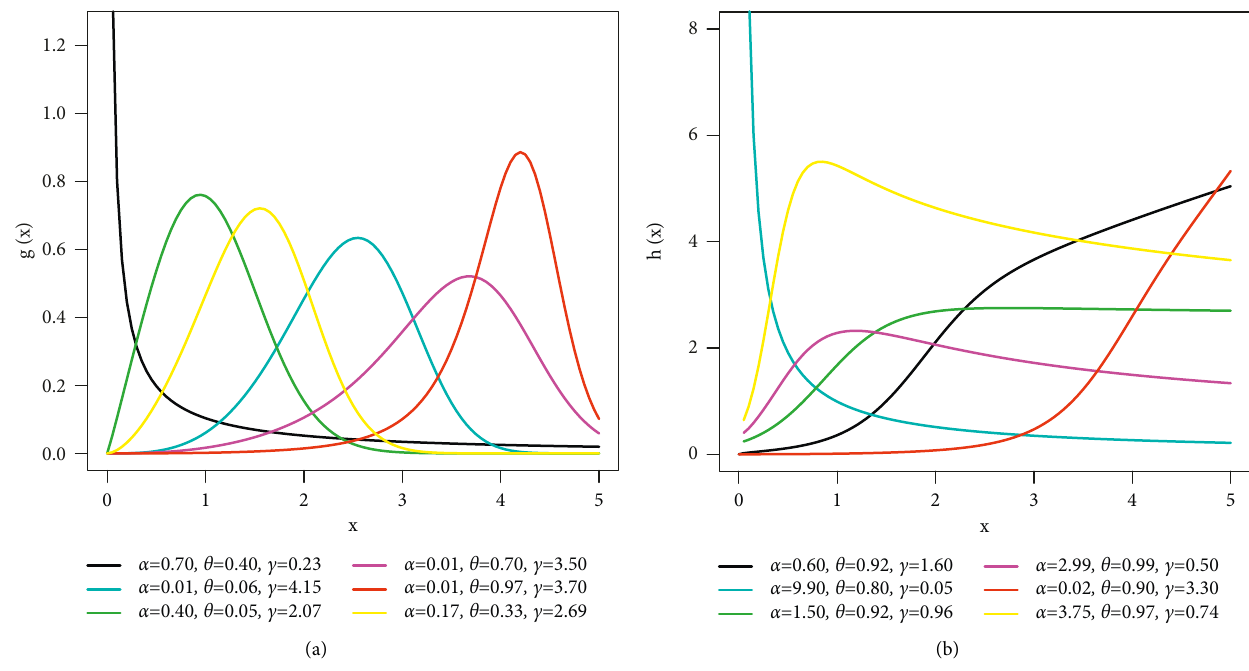
Figure 2: (a) PDF and (b) HRF plots of the SWGII